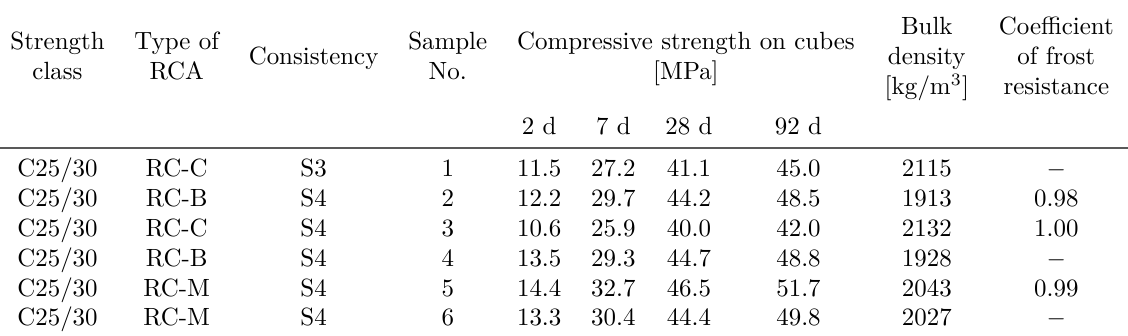
Table 2. Results of laboratory tests prior start of industrial production.